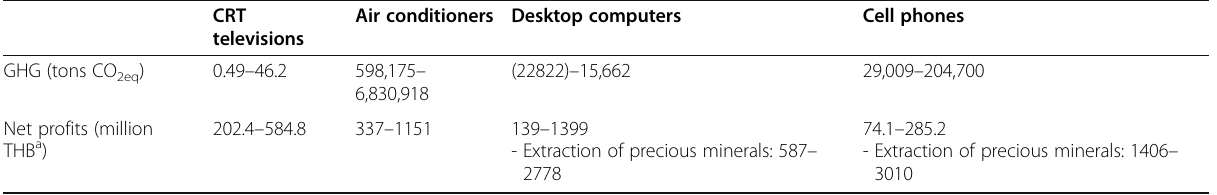
Table 7 Life cycle GHG and LCC assessment results of end-of-life products in 2019 CRT